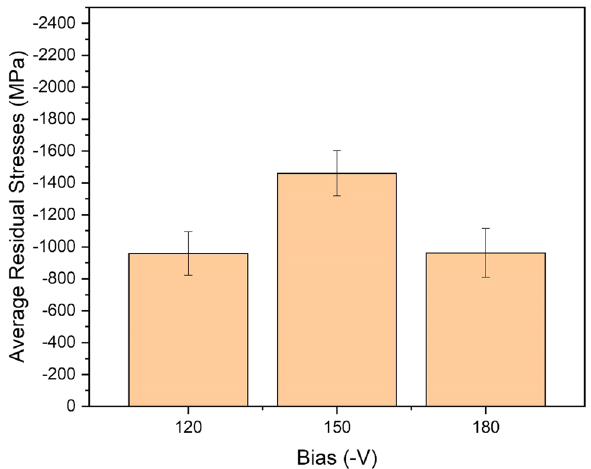
Figure 3. Residual stress evolution in the CrN/Cr 1-x Al x N multilayers deposited onto gas nitrided diesel piston rings at 1 rpm as a function of the bias level.